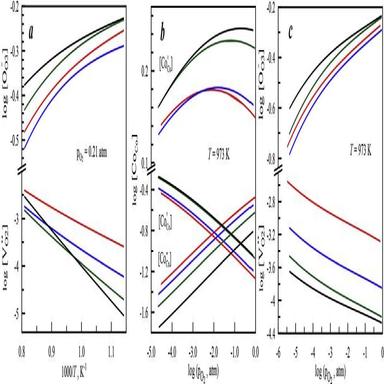
The changes in equilibrium concentrations of oxygen and cobalt species in PBC (black), PYBC (green), PBCN (blue) and PYBCN (red) with temperature (a) and oxygen partial pressure (b), (c). (For interpretation of the references to colour in this figure legend, the reader is referred to the Web version of this article.)